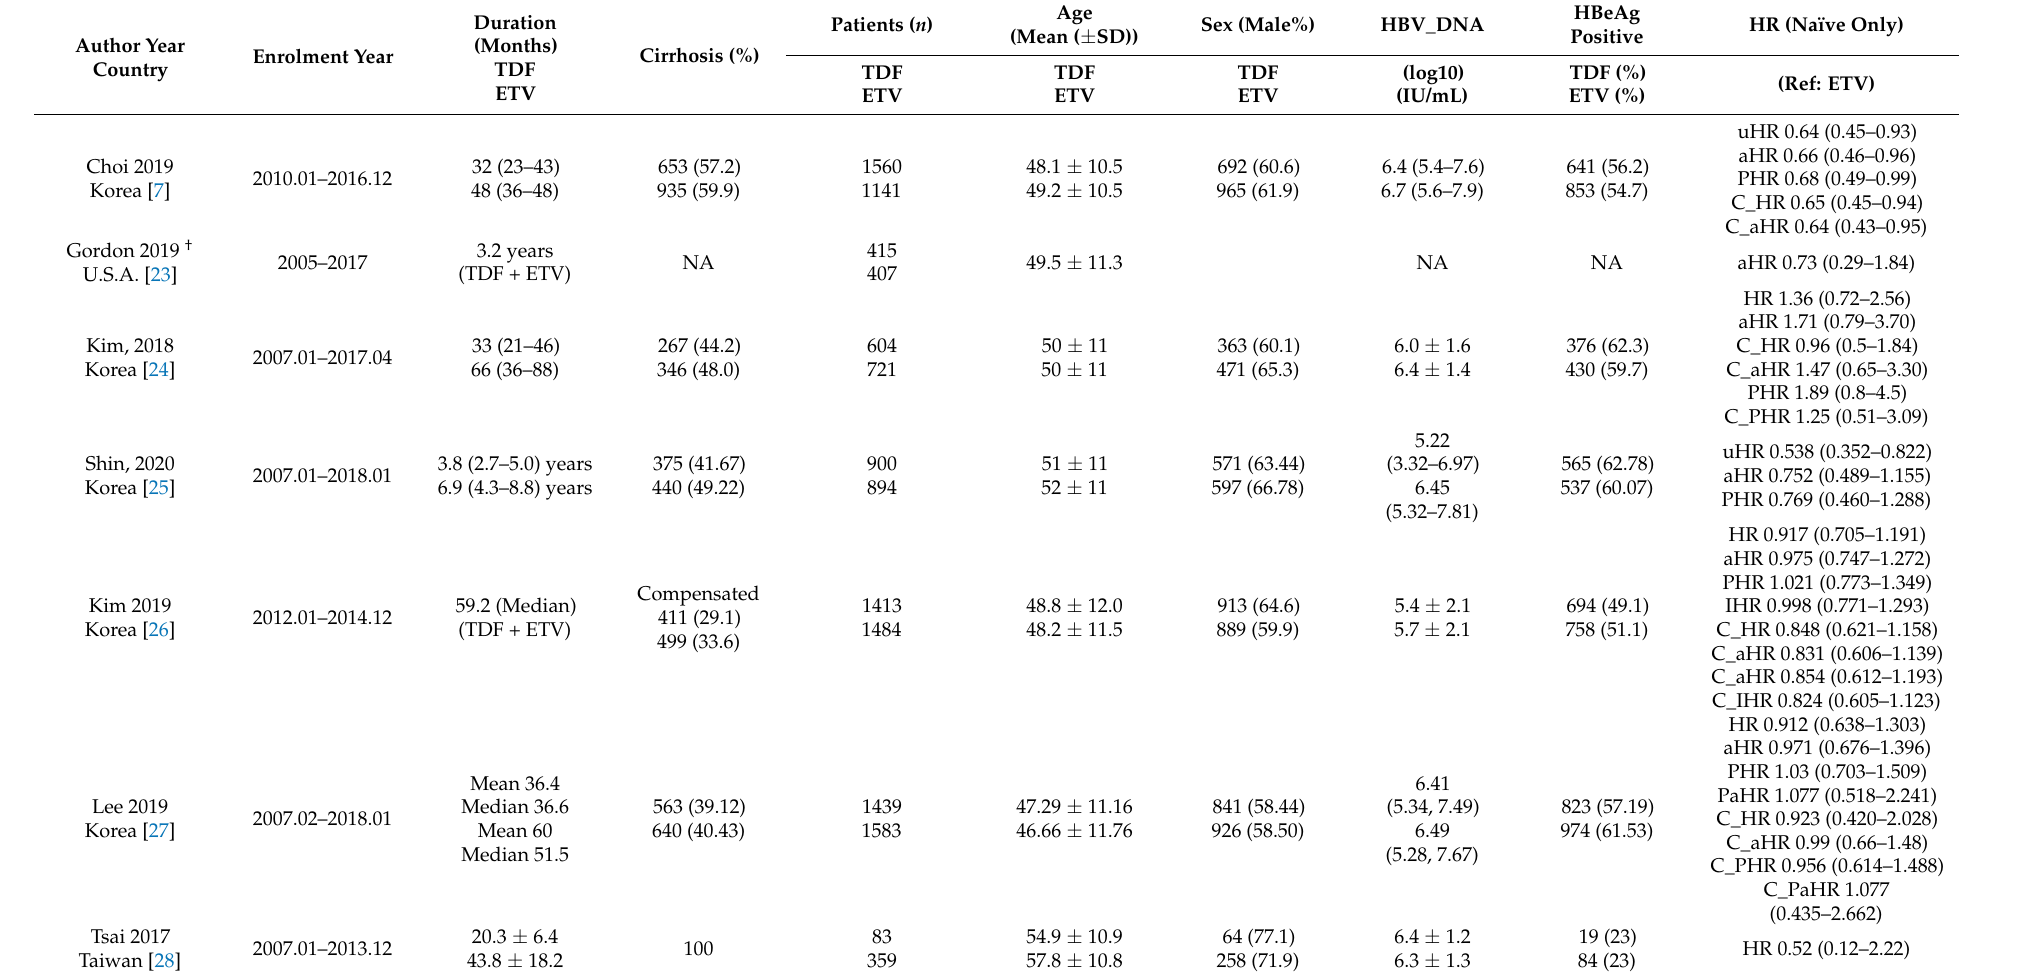
Table 1. Main characteristics of the included studies (all studies were retrospective observational studies, and the number of decimal places is borrowed from the adopted